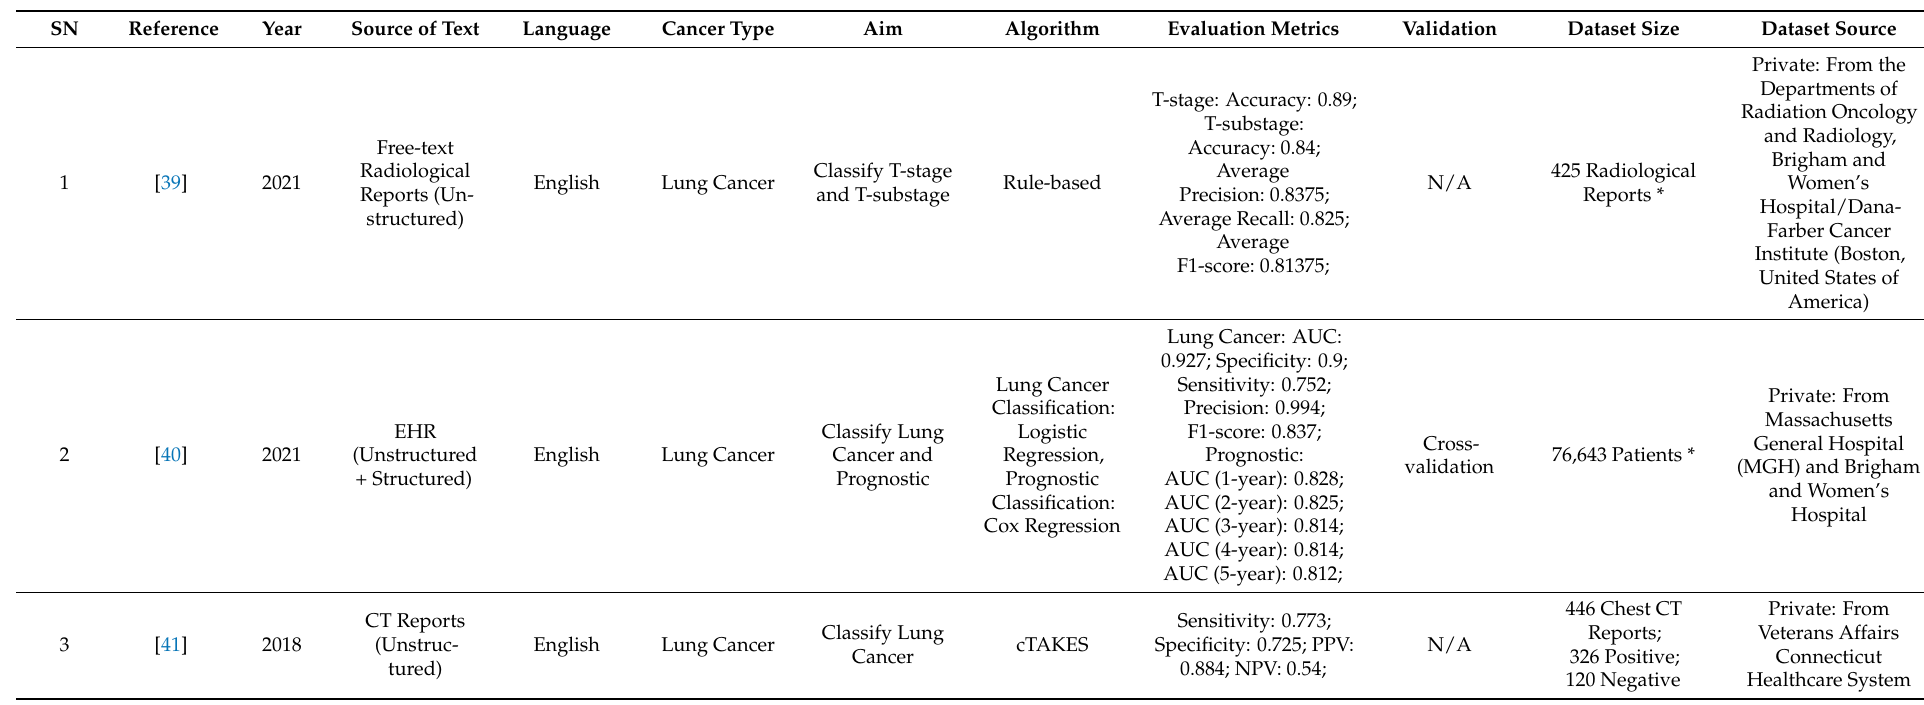
Table 5. Lung cancer-related studies. * represents that we only show the size of the dataset because the dataset has too many types of data (more than three), the distribution of the dataset is not fully described, or it is not easy to show the structure of the dataset for other